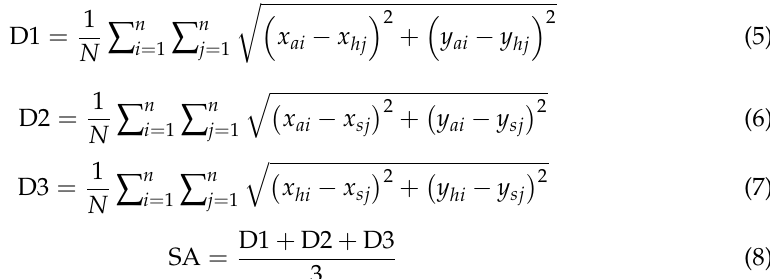
Figure 7. The calculation method for the SA parameter. D1 = (cid:2869) (cid:3015) ∑